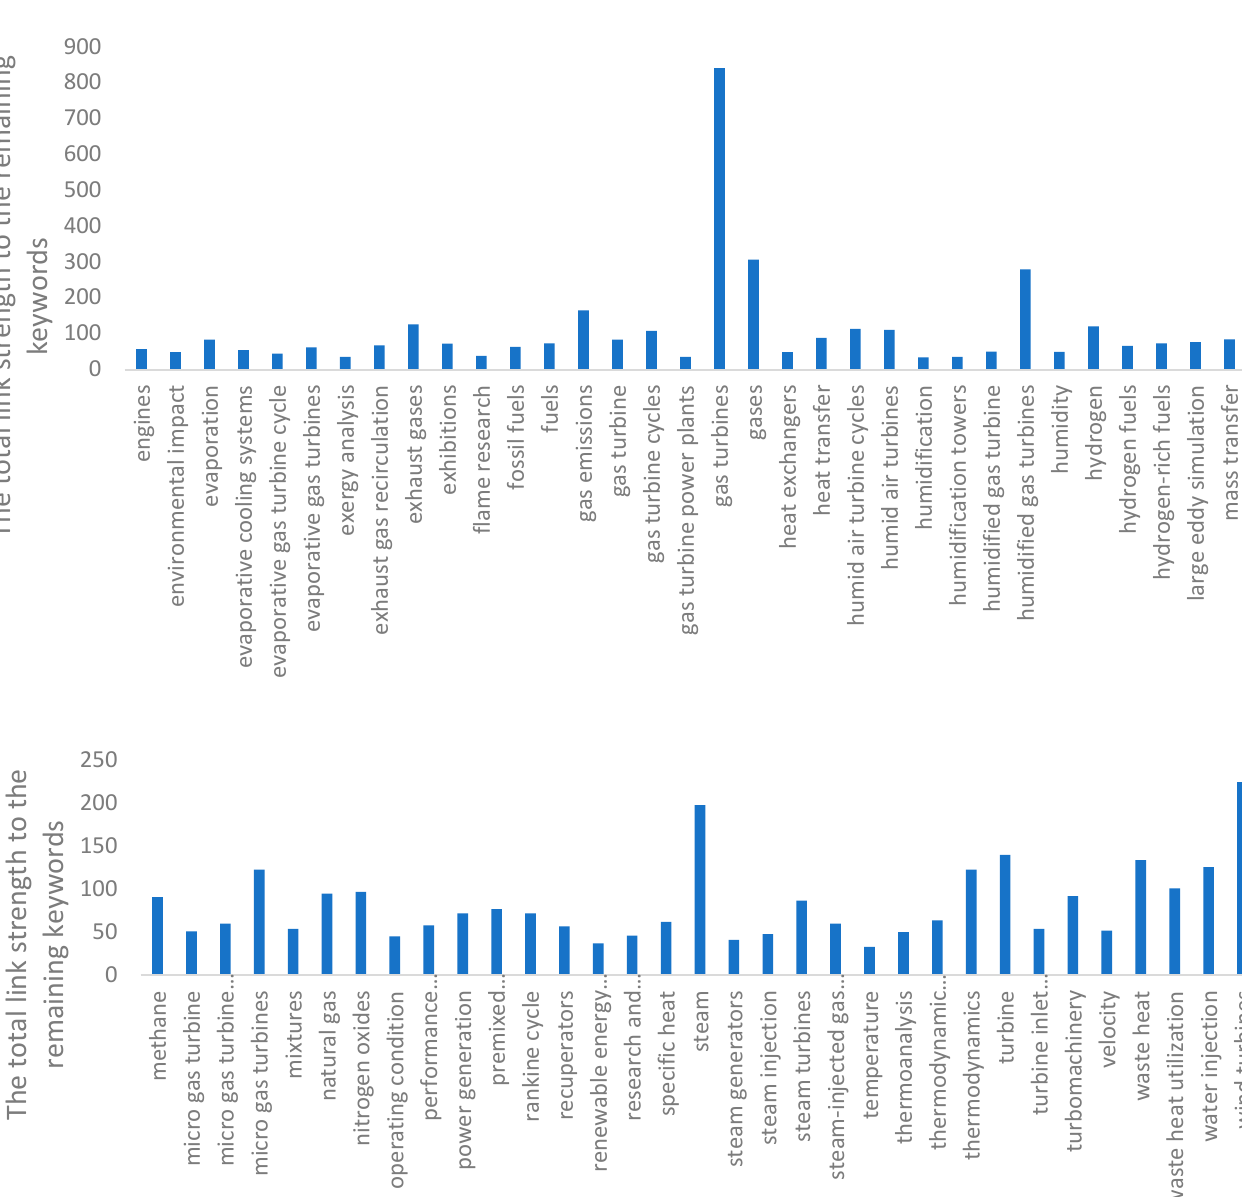
Figure 14. The link strengths of the keywords to each other (a higher numerical value represents a stronger link to the other keywords).